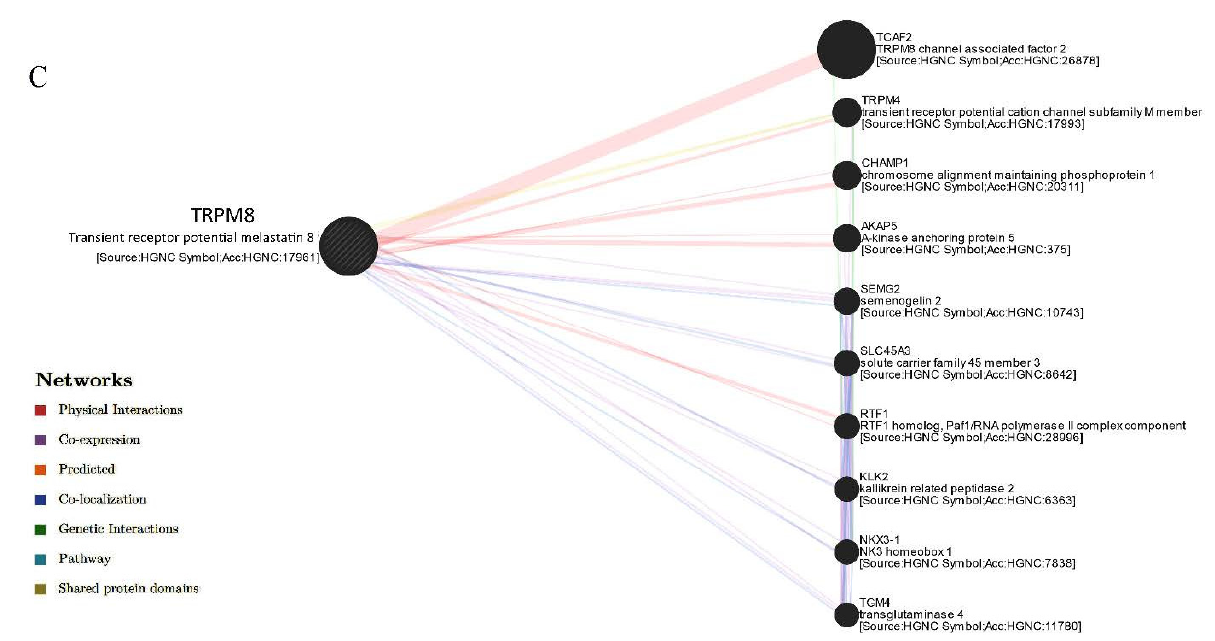
Figure 3. Co-expression/pathway/predicted analysis of TRPV6 ( A ), TRPA1 ( B ), and TRPM8 ( C ) and 10 related genes according to human expression data in GeneMANIA (https://genemania.org/), created on 27 July 2022.